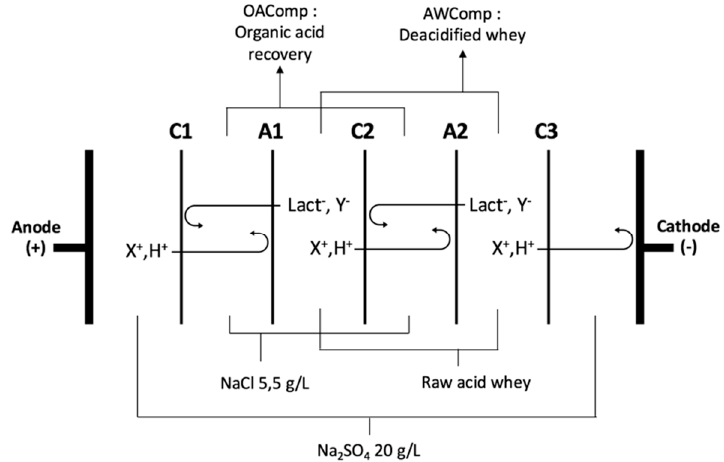
Figure 1. Electrodialysis (ED) configuration (CACAC, letters corresponding to the membrane’s stacking) used for acid whey deacidification. C refers to cation exchange membrane and A to anion exchange membrane. X+ and Y- refer to cations and anions, respectively, present in the whey. (modified from Dufton et al. 2018 [10]).